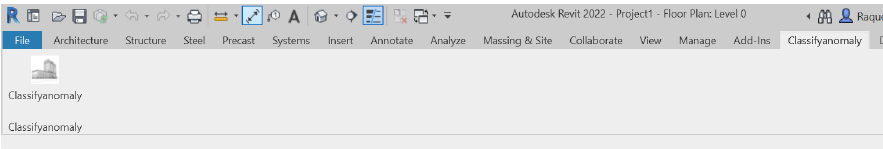
Figure 6. Add-in integrated in Revit software Ribbon to access the app to classify images by means of Binder.